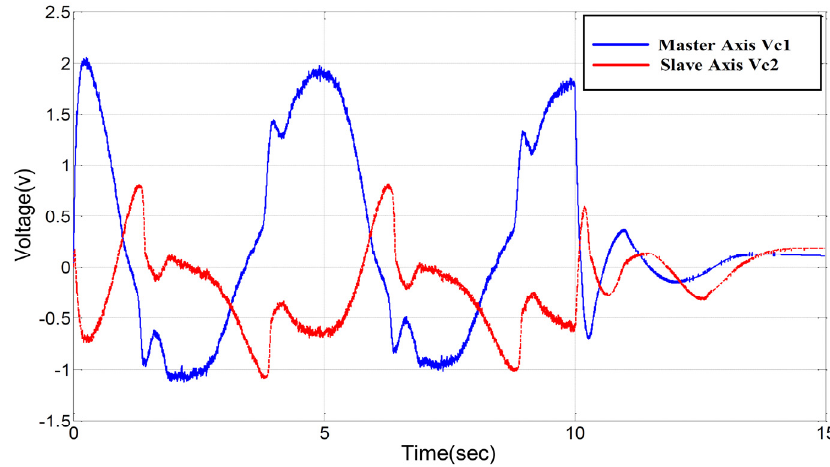
Figure 11. Control efforts of the cascade synchronous control method.